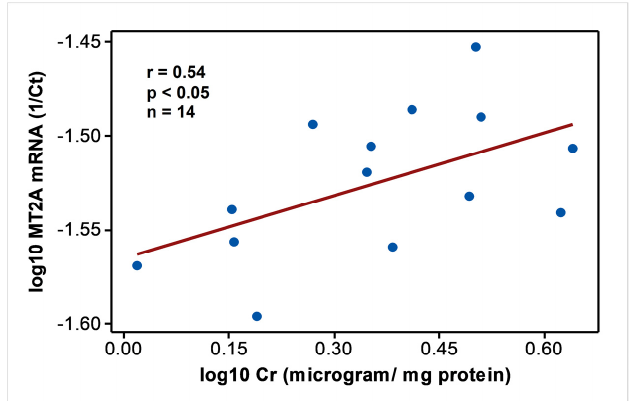
Figure 1. Variation in blood MT1A and MT2A mRNA levels during CRF progression in CKDu endemic area. MT; metallothionein, Ct; cycle threshold (RTPCR), EC; endemic control, and G1-G5; CKD stage groups, NEC; nonendemic control. n = 110. Log10 MT data are shown as mean and 95% confidence interval in linear scale Y axes. a and b indicate significance at p < 0.01 between two means (one-way ANOVA, Tukey HSD).